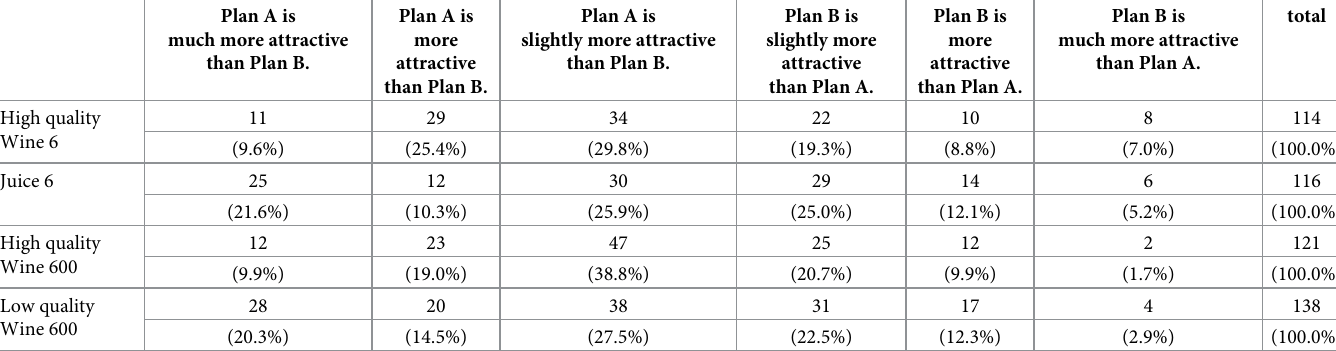
Table 7. Frequencies and percentages of choice in the Drink problem across 4 categories without minority (negative frame). Plan A is much more attractive than Plan B.